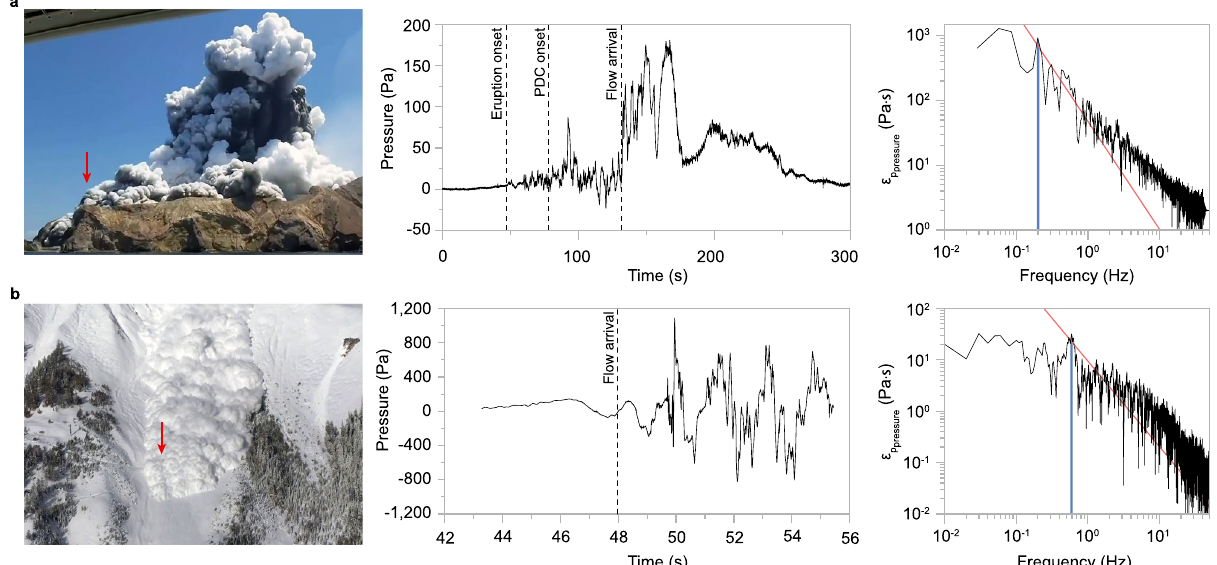
Fig. 8 Direct measurements of pressure inside natural pyroclastic surges and snow avalanches. The fi rst pressure measurements inside pyroclastic density currents during the December 9 2019 eruption of Whakaari (White Island) in New Zealand in comparison with pressure measurements inside powder snow avalanche #20163017 in Vallée de la Sionne (Switzerland). a left: view to the West of Whakaari volcano during the December 9 2019 eruption with the collapsing eruption column in the centre-right of the image and the pyroclastic surges advancing from right to left along the crater fl oor and billowing over the crater walls. The red arrow marks the location of the WIZ infrasound sensor situated at the far ridge on the south-western side of the crater fl oor. Middle: time series of pressure recorded by an infrasound sensor. Vertical dashed lines indicate the times of eruption onset, onset of PDC propagation at the base of the collapsing eruption column and PDC arrival at the sensor. Right: energy spectrum of pressure ε P highlights the most energetic frequency at 0.199Hz. b left: frontal view of powder snow avalanche #20163017 55 . The red arrow marks the location of the pylon-mounted pitot tube sensor that becomes engulfed by the left edge of the avalanche. Middle: time series of pressure recorded by the pitot tube. The vertical dashed line indicates the times of avalanche arrival at the sensor. Right: energy spectrum of pressure ε P the most energetic frequency at 0.6 Hz. Red lines mark the -5/3 Kolmogorov law of the inertial range of the energy cascade. Part a image courtesy of Allessandro Kauffmann (top); part b image courtesy of Bettina Sovilla